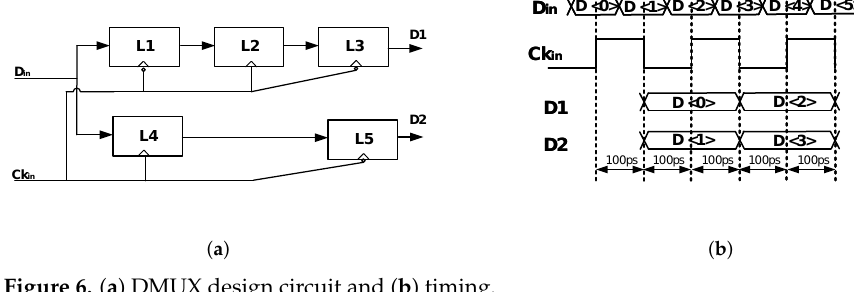
Figure 6. ( a ) DMUX design circuit and ( b )